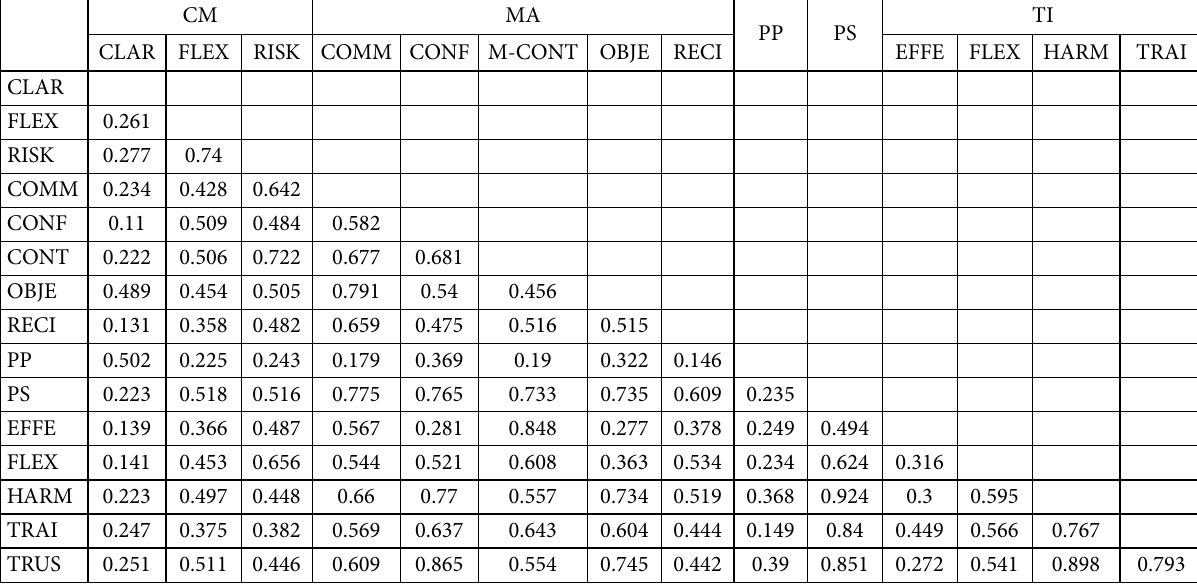
Table 4. HTMT Values for LOC